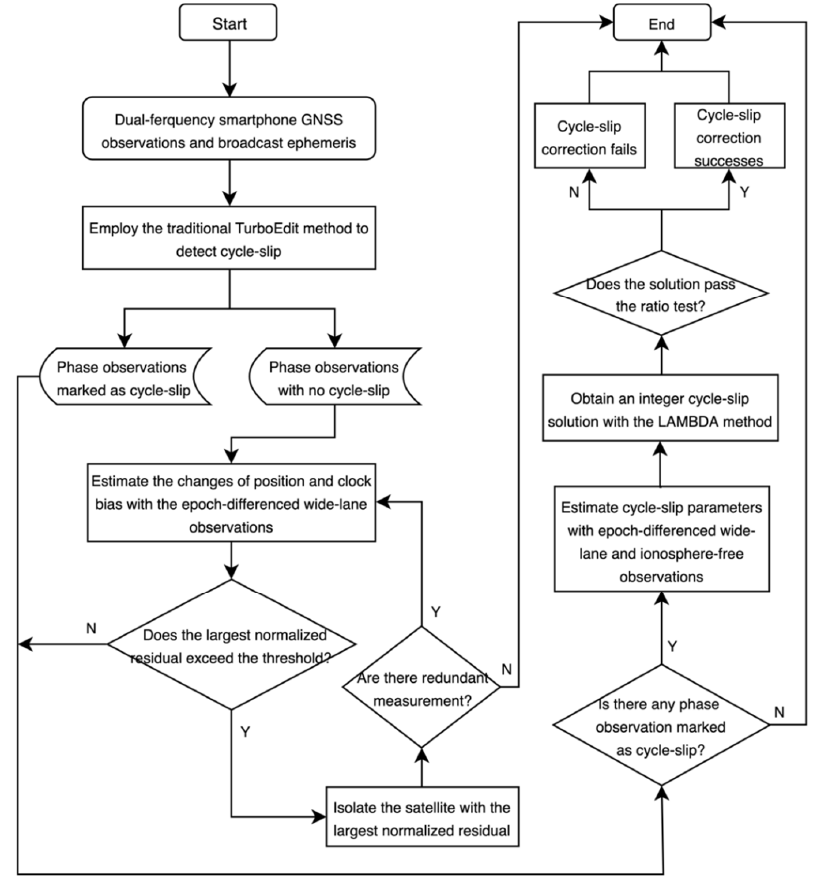
Figure1. Procedureof themodifiedTurboEditmethod fordual-frequencysmartphoneglobalnavigation Figure 1. Procedure of the modified TurboEdit method for dual-frequency smartphone global satellite system (GNSS) navigation satellite system (GNSS) observations.